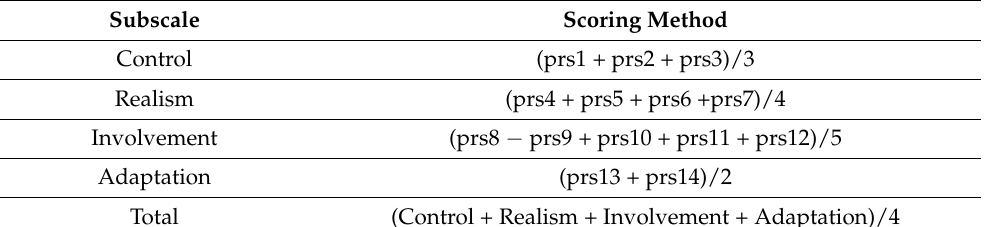
Table 1. Presence scoring method (prs: presence